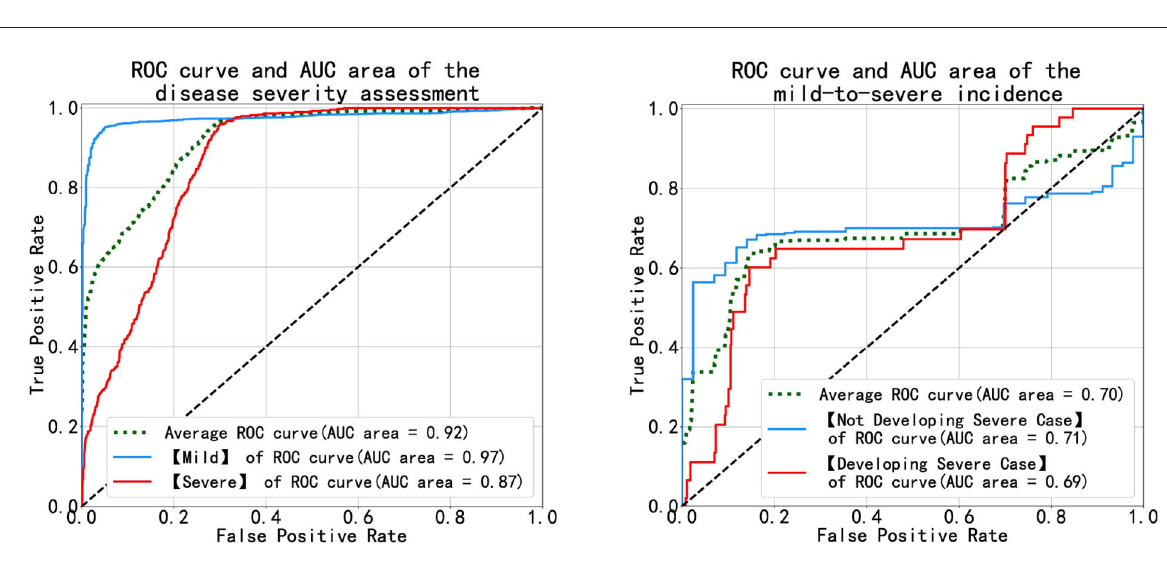
FIGURE7 Diagrams of the ROC and AUC of the disease severity assessment (left) and the disease progression prediction (right)